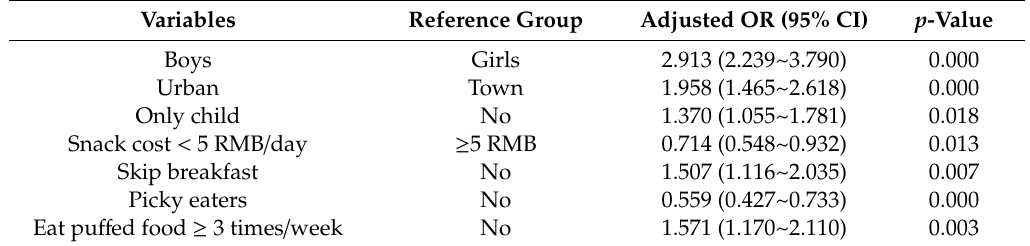
Table 4. Logistic regression analysis of the factors of overweight / obesity among school-age children. Variables Reference